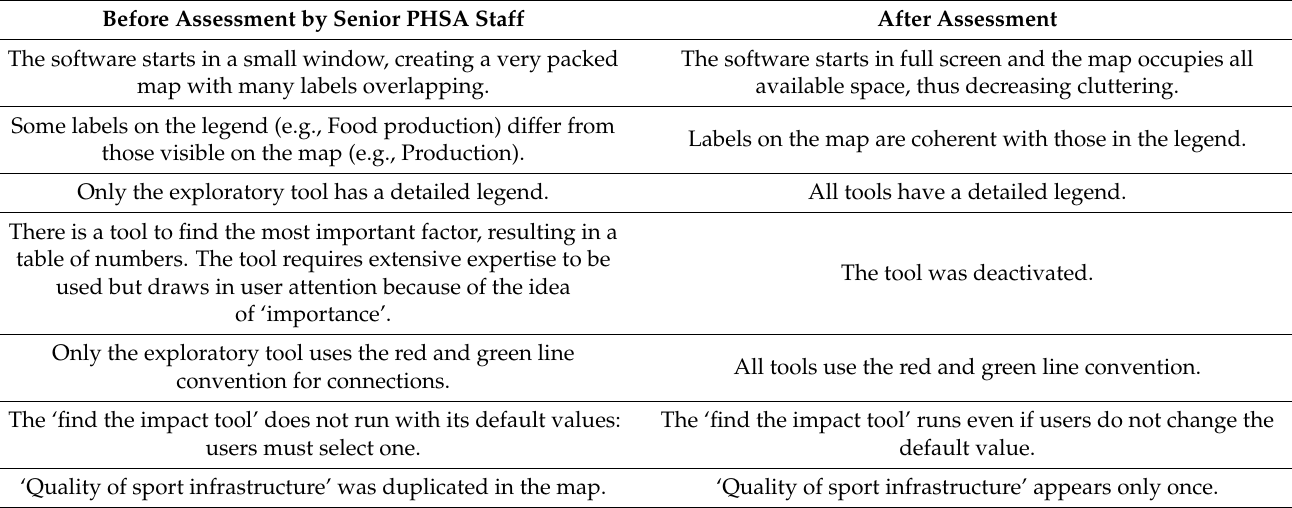
Table 1. Software changes made after a review by senior staff at the Provincial Health Services Authority (PHSA) of British Columbia,